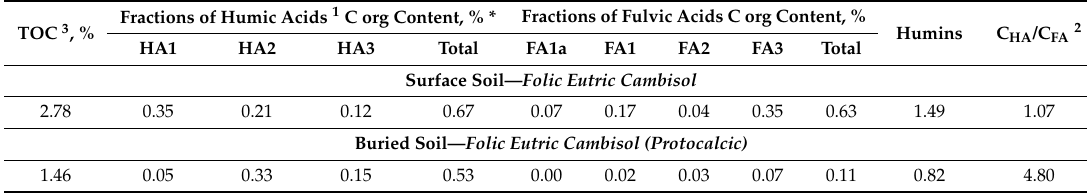
Table 3. Characteristics of